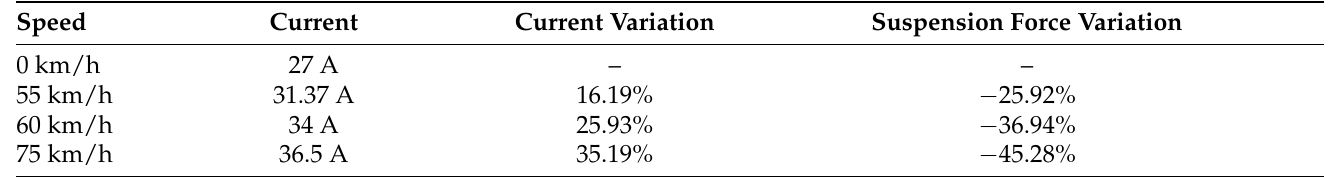
Table 3. Influence of eddy current effect on suspension system under different